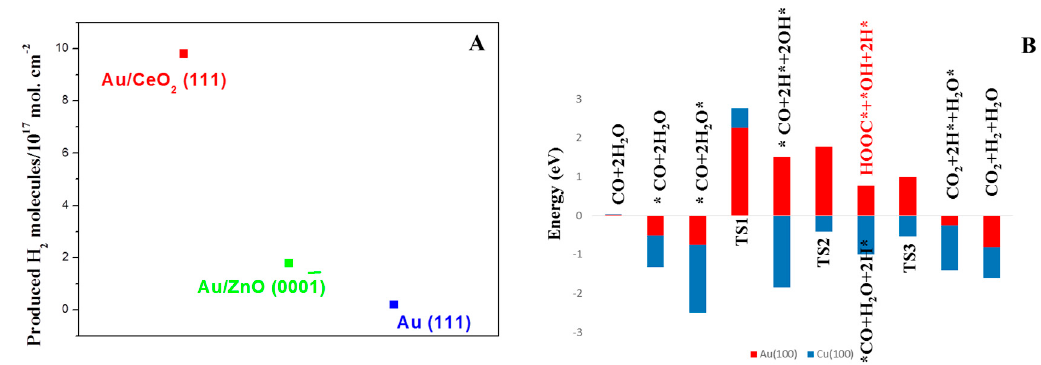
Figure 8. ( A ) Catalytic activity of model WGS catalysts; ( B ) WGS reaction energy profile over Au (100) and Cu (100). Adapted from Rodriguez [146].